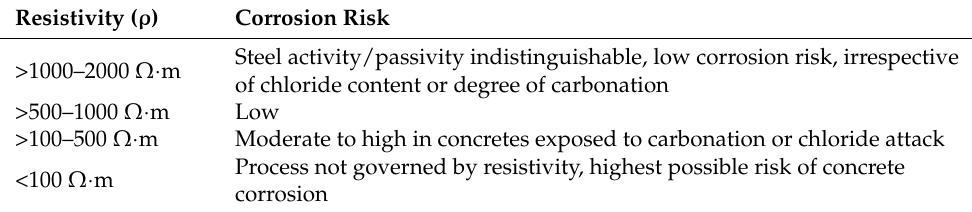
Table 1. Corrosion risk assessed in terms of resistivity ( ρ